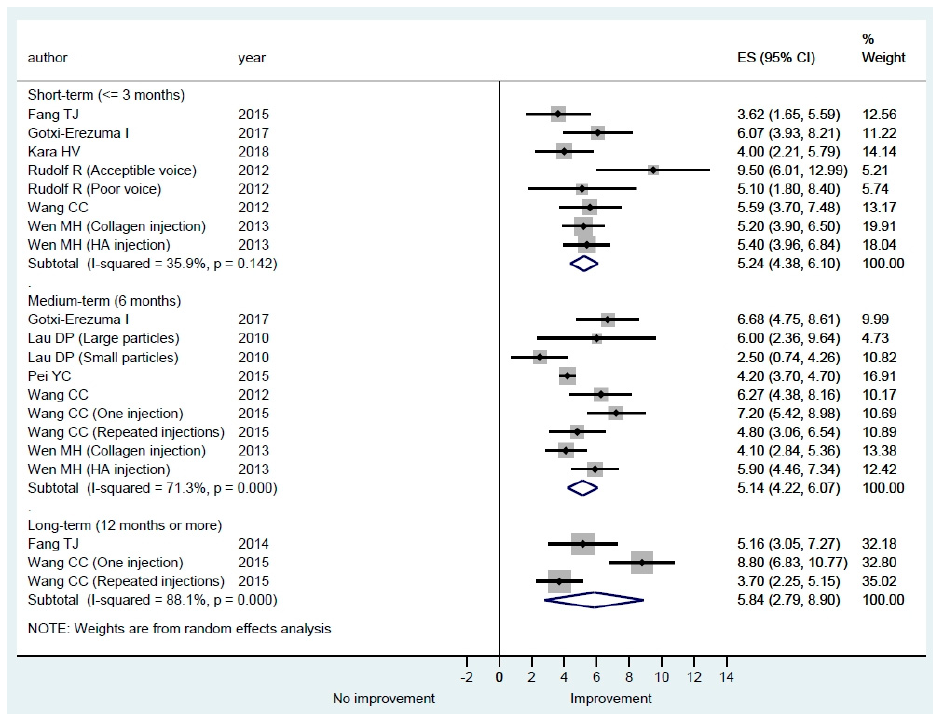
Figure 4. Subgroup meta-analysis of overall maximal phonation time (MPT) in short-term, medium-term, and long-term follow-up after hyaluronic acid injection laryngoplasty.